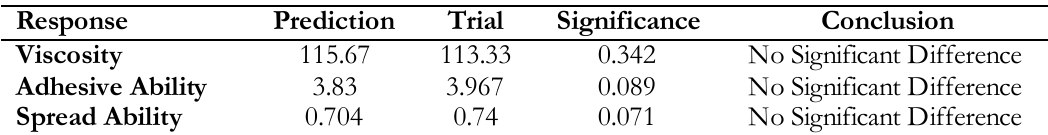
Tabel II. The result of T-test between prediction physical characteristic and experimental physical characteristic of o/w cream